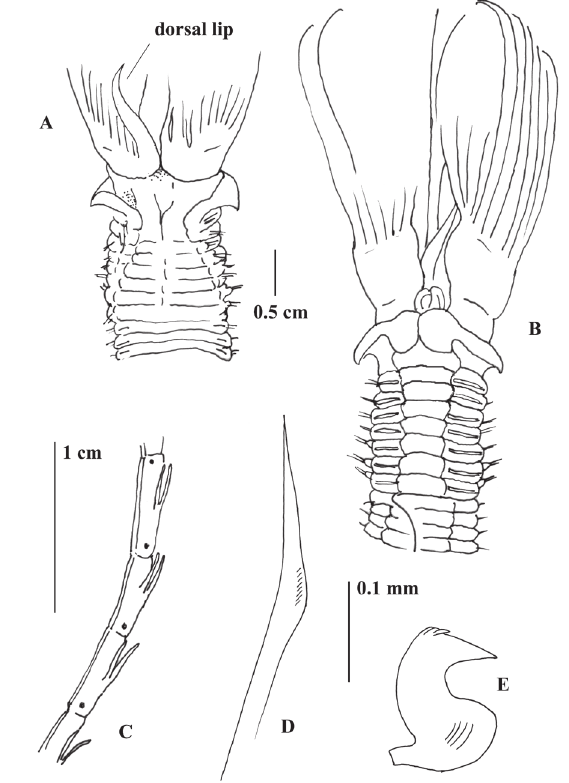
Fig . 3. – Branchiomma luctuosum : A, anterior end, dorsal view; B, anterior end, ventral view; C, detail of radiole, showing stylodes and radiolar eyes; D, thoracic inferior notochaeta; E, thoracic